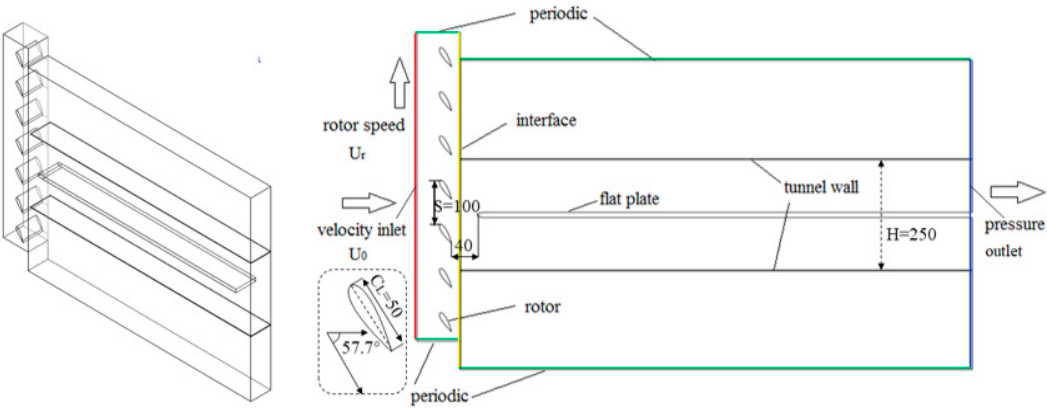
Figure 1. A global view of the computational domain, left: 3D schematic of geometry (spanwise × 10), right: plane view with boundary conditions.